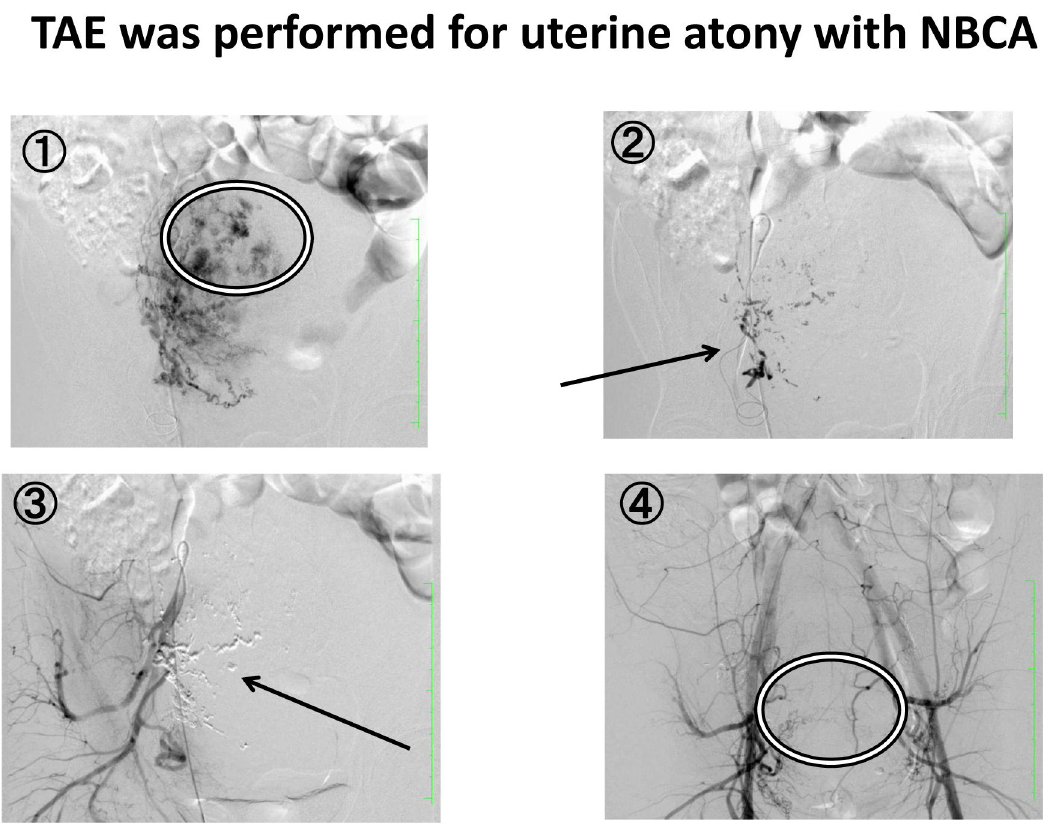
Figure 3. Uterine artery embolization with NBCA. (1) A catheter is inserted from the left or right femoral artery, arteriography of surrounding arteries is performed, and extravasation of the contrast medium is confirmed (inside circle). (2) The catheter is selectively advanced in arteries in which extravasation is confirmed, and the prepared NBCA mixture is injected. The flow of the injected NBCA mixture along the vessel could be confirmed while watching the contrast effect on perspective images (arrow) (3). The NBCA mixture hardens with time and embolises the site of bleeding. It can be visualised as a transparent solid substance on perspective images (arrow) (4). Contrast medium is used again after embolisation, but no obvious extravasation is seen, and reliable haemostasis has been achieved (inside